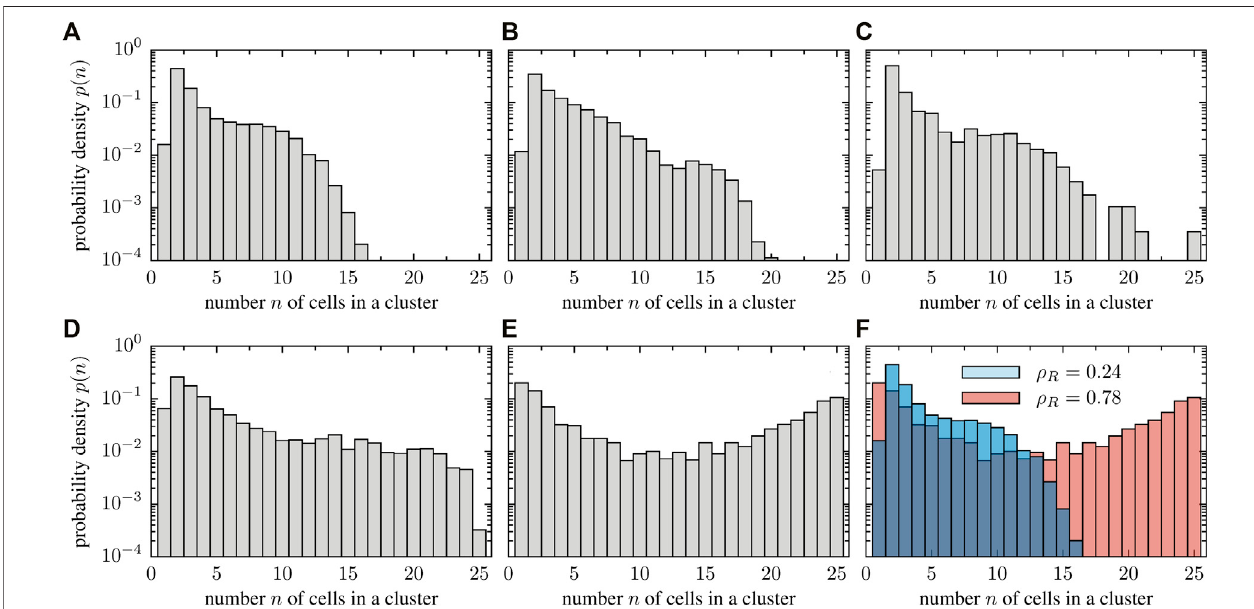
FIGURE9| Histogramsoftheobservedclustersizesforvariousparticledensities.Thecellnumberwaskeptconstant( N =25cells)andthesystemsizewasvaried. The packing fractions values of the different panels are (A) ρ R = 0.24, (B) ρ R = 0.30, (C) ρ R = 0.40, (D) ρ R = 0.54 and (E) ρ R = 0.78. For increasing packing fraction, the cluster size distribution changes from a unimodal to a bimodal structure, signaling a clustering transition. This transition is highlighted in the last panel (F) , where the cluster size distribution for low and high packing fraction is overlayed to simplify the comparison.